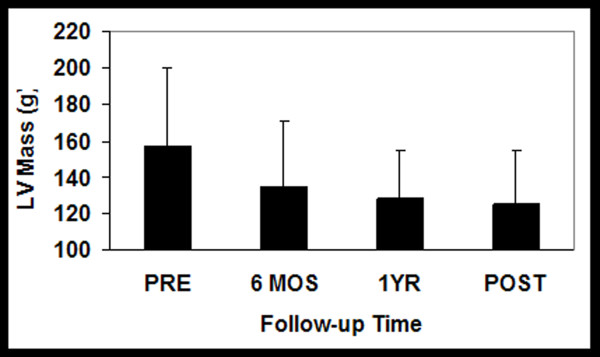
Plots of the temporal nature of the pattern of LVH regression serially out to 4 years. Note the immediate LVH regression sparked by the massive afterload relief by AVR. However, the trajectory of initial regression at 6 months would have predicted a far greater mass reduction then evident at 4 years.